Question: Provide a one-line summary of what is displayed.
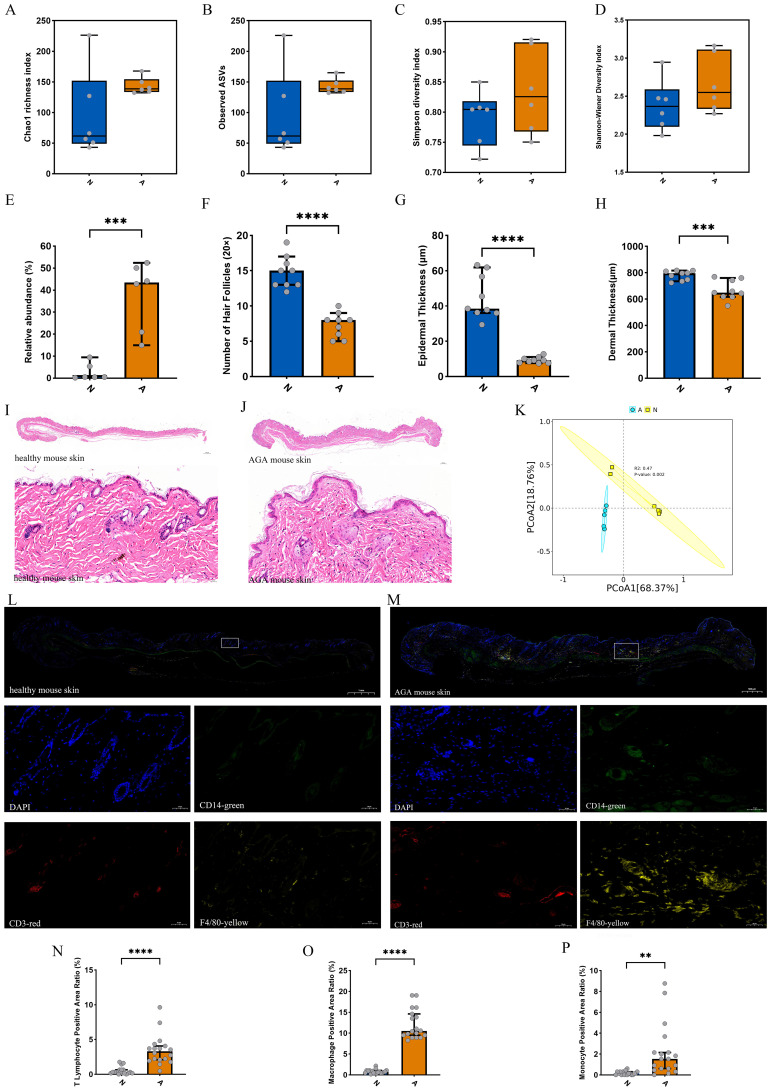
Answer: Diversity, histological and immunological traits of mouse skin tissues. (A–D) α-diversity indices including Chao1 richness (A) , number of observed ASVs (B) , Simpson index (C) , and Shannon index (D) were compared between healthy (N) and AGA (A) mice. (E) Relative abundance of Staphylococcus at the genus level was compared between groups. (F–H) Histomorphometric analyses quantified hair follicle density (F) , epidermal thickness (G) , and dermal thickness (H) . (I, J) Representative hematoxylin and eosin (H&E)-stained skin sections from healthy (I) and AGA (J) mice. (K) Principal coordinate analysis (PCoA) based on unweighted UniFrac distance illustrates β-diversity of bacterial community composition. (L, M) Immunofluorescence micrographs of skin tissues from healthy (L) and AGA (M) mice, stained for DAPI (nuclei, blue), CD14 + cells (green), CD3 + T lymphocytes (red), and F4/80 + macrophages (yellow). (N–P) Infiltration levels of CD3 + T cells (N) , CD14 + cells (O) , and F4/80 + macrophages (P) were quantified.Data are presented as mean ± s.d. N, healthy mice; A, androgenetic alopecia mice. Statistical significance for α-diversity indices was determined using multivariate linear regression and ANOVA. For other comparisons, a two-tailed Mann-Whitney U test was used ( P : **< 0.01 ***< 0.001 ****< 0.0001).).